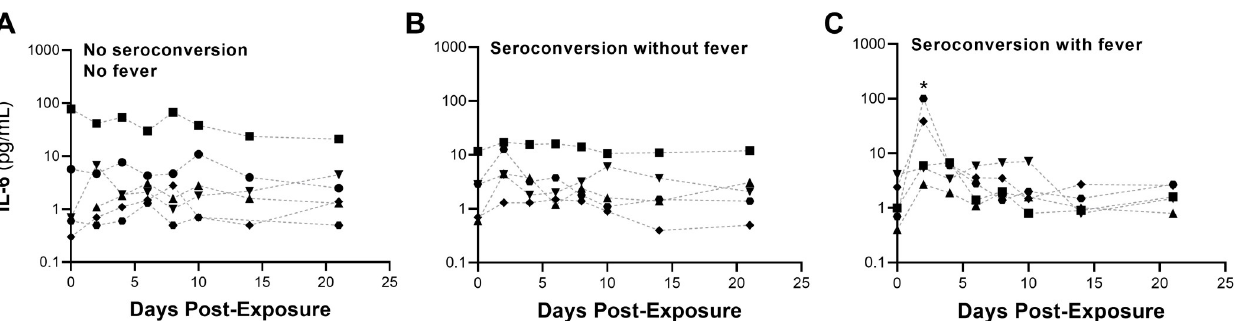
Fig 3. Serum IL-6 Profiles. (A) IL-6 serum concentrations over time are shown for animals that did not seroconvert or have fever (n = 6). IL-6 concentrations at all post-exposure time points were not significantly different than the baseline IL-6 levels. One animal in this group had a significantly higher baseline and post-exposure levels than the other animals, and appears to be an outlier. (B) IL-6 serum concentrations over time are shown for animals that seroconverted but did not have fever (n = 5). IL-6 concentrations at all post-exposure time points were not significantly different than the baseline IL-6 levels. (C) IL-6 serum concentrations over time are shown for animals that seroconverted and had fever (n = 5). IL-6 levels increased on day 2 in all animals in this group relative to baseline, but two of the five animals had increases that were much greater than the others ( > 35 pg/mL, and > 10x baseline), reaching levels reported for severe cases of COVID-19 in humans. IL-6 levels returned to baseline levels by day 4 post-exposure; � denotes P < 0.05 when compared to the day 0 baseline